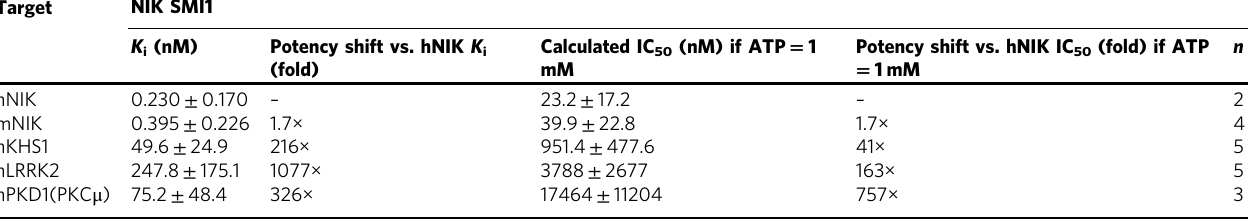
Table 1 Potency of NIK SMI1 for NIK and most affected off target